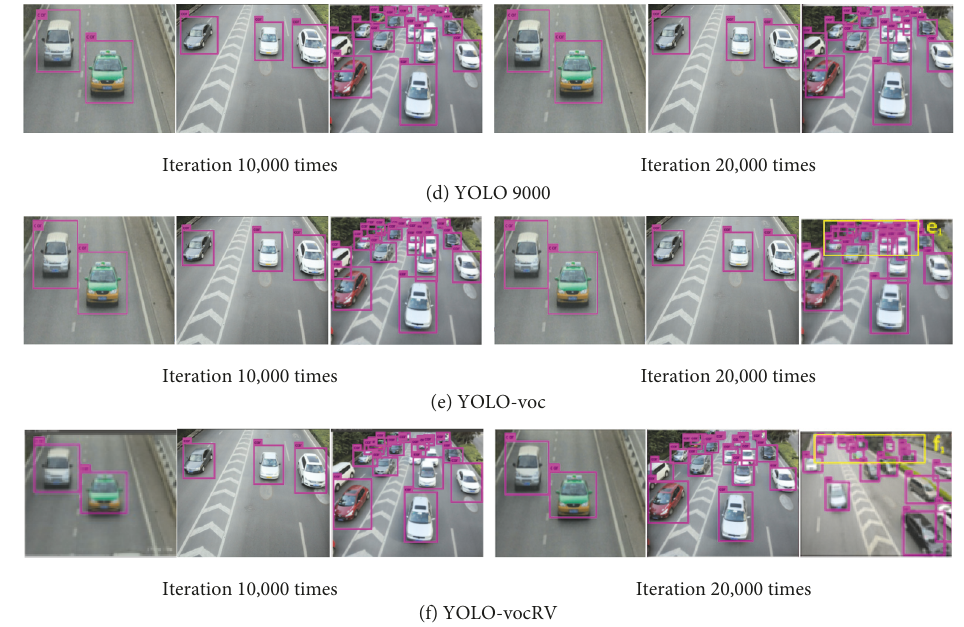
Figure 13: Test results for training samples with synchronous flow.